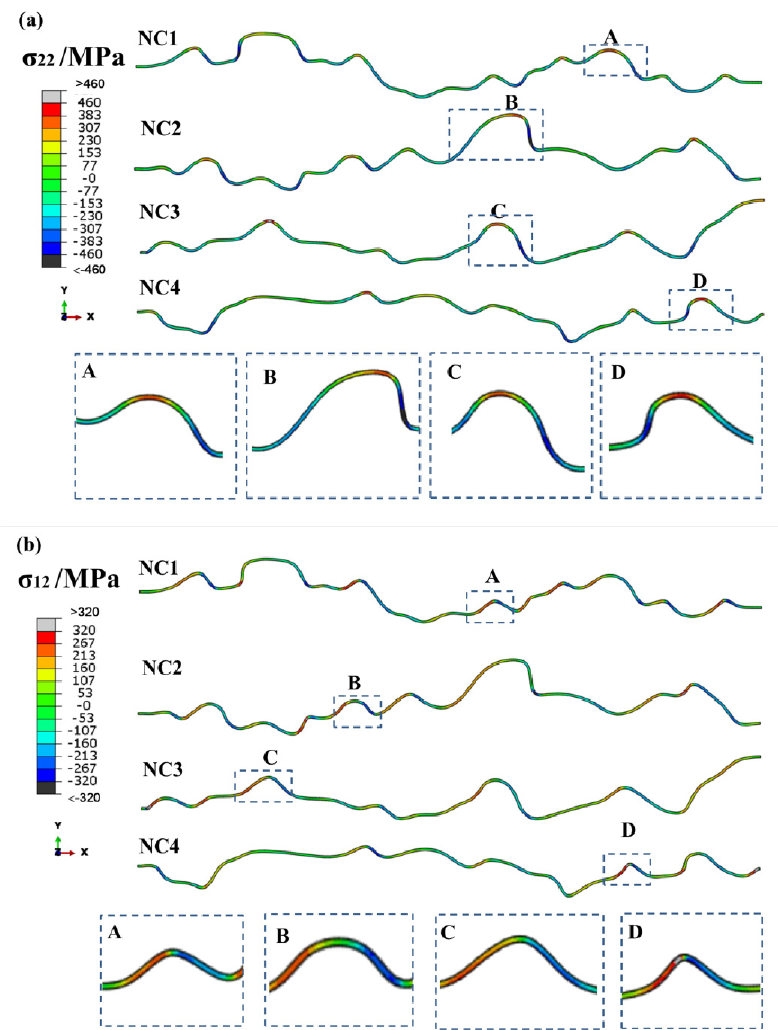
σ σ 22 and ( b ) 12 stress distribution in TGO